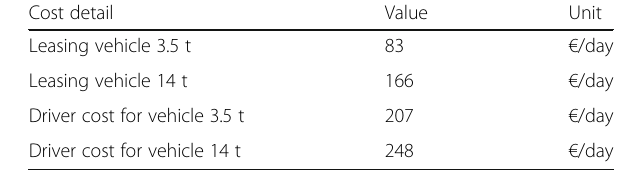
Table 7 VRP economic parameters per